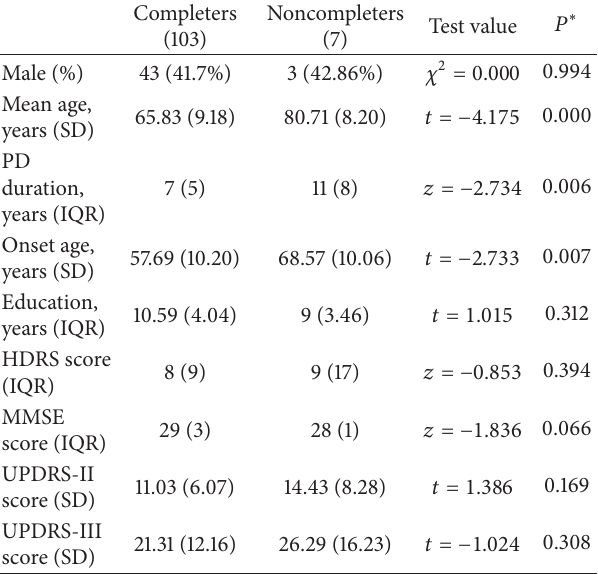
Table 1: Baseline clinical and sociodemographic characteristics of completers and